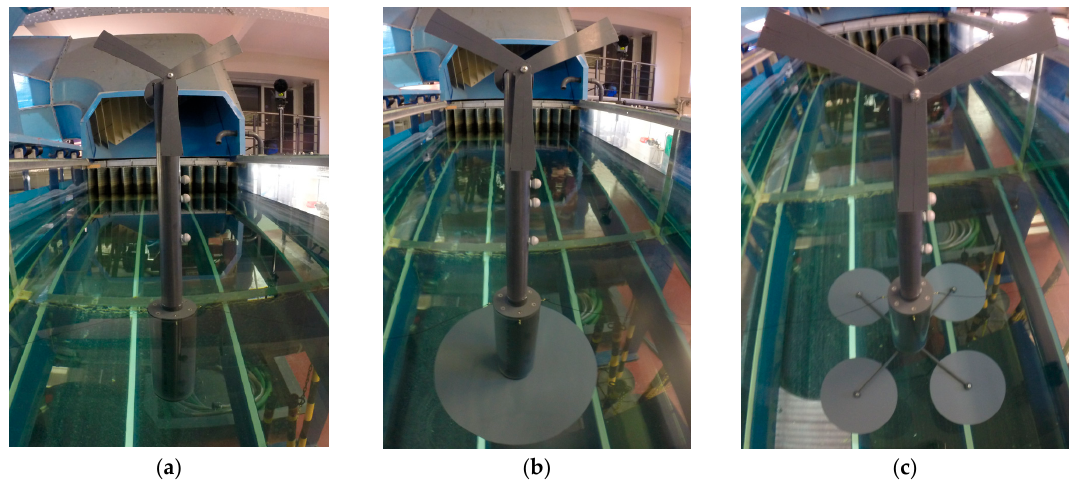
Figure 8. “Amplified” turbine used in experimental tests—( a ) without using a stabilizer; ( b ) using a single plate; and ( c ) using a four-wing stabilizer.